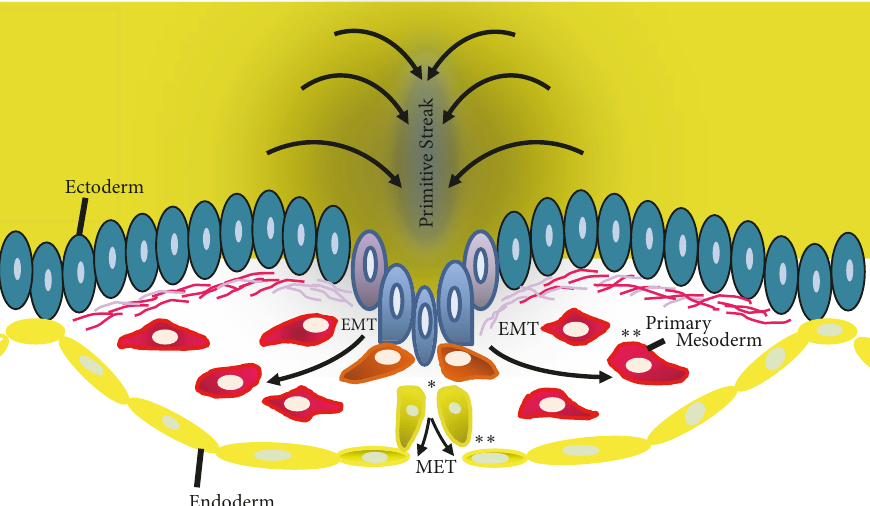
Figure 2: Human gastrulation and Kaiso. During gastrulation, ectodermal cells at the primitive streak undergo epithelial-mesenchymal transition (EMT) as a result of signals produced by the Spemann organizer or internal determinants. Also during this process the epiblast cells, in response to these signals, translocate Kaiso to the cytoplasmic compartment ( ∗ ) and thus these cells ingress through the primitive streakandmigrateintotheunderlyingtissue.Inasecondcriticalmoment,thedelaminatingcellstranslocateKaisotothenuclearcompartment ( ∗∗ ) and will form the primary mesoderm or will undergo mesenchymal-epithelial transition (MET) establishing the endoderm. Adapted from